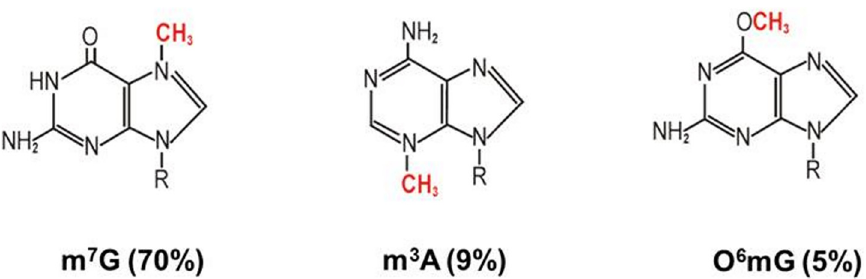
Fig 1. The main reaction products of the TMZ reaction with DNA. 7-methylguanosine (m 7 G) is the most abundant product (60–80%) of TMZ reaction with DNA, followed by 3-methyladenosine (m 3 A, 10–20%) and O6-methylguanosine (O 6 mG, 5%). Other products constitute ca. 15% [17].